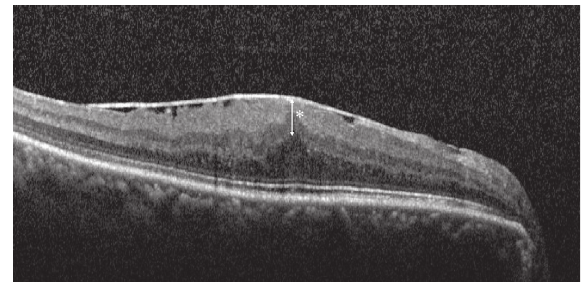
Figure 1: An ectopic inner foveal layer (EILF). The EIFL (asterisk) on the optical coherence tomography image indicates the presence of continuous hyporeflective and hyperreflective bands extending from the inner nuclear layer and inner plexiform layer across the foveal